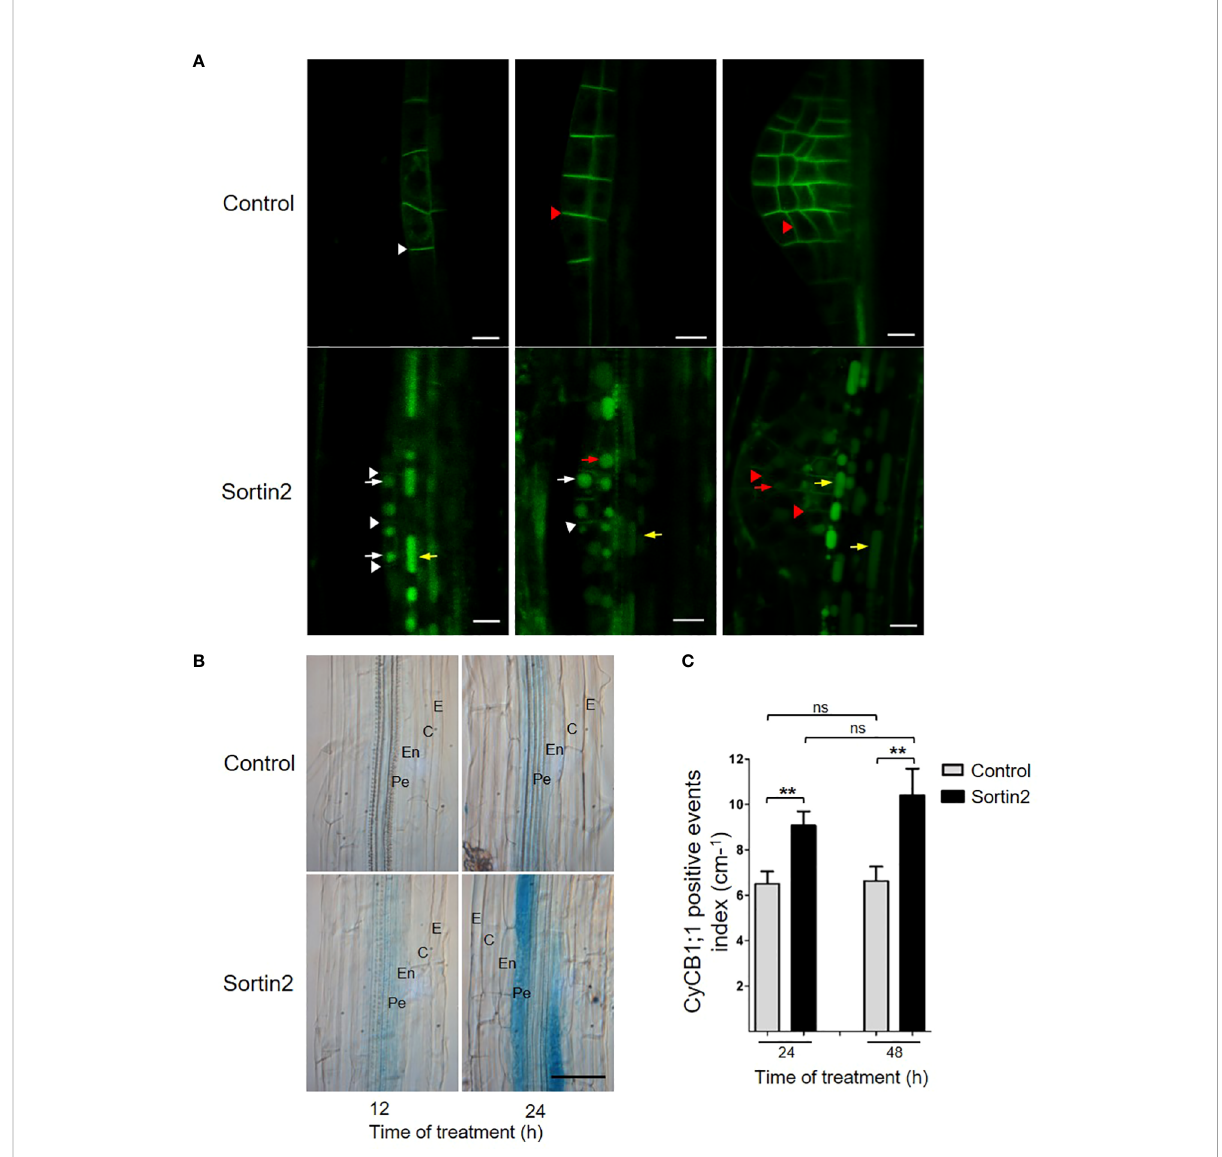
FIGURE 1 Sortin2 exerts its effect in pericycle cells. (A) pPIN1::PIN1-GFP transgenic Arabidopsis seedlings were treated for 12 hours with Sortin or control conditions. The localization of PIN1-GFP (green) in roots was evaluated. Stages of lateral root primordium were de fi ned according to Malamy and Benfey (1997). Images are representative of seedlings in three independent experiments ( n ≥ 9 seedlings). Arrows and arrowheads indicate the plasma membrane and vacuoles, respectively, in pericycle cells (yellow), lateral root founder cells (white), and primordium cells (red). Scale bars = 10 m m. (B, C) Seven-day-old p CYCB1;1 ::GUS reporter line seedlings were treated with Sortin2 for 12, 24, and 48 hours (or not treated, for controls), and their GUS activity was evaluated. (B) Bright fi eld images of GUS activity in seedlings treated with Sortin2 for 12 and 24 hours,